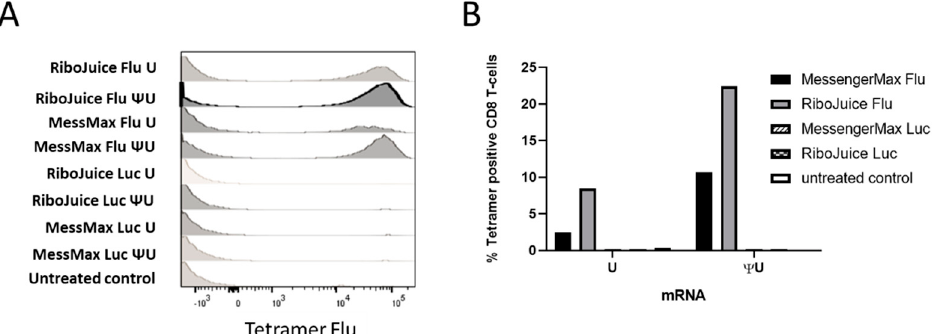
Figure 4. Monitoring of Flu M1-specific immune responses in human PBMCs following transfection with ivt mRNA coding the Flu matrix M1 protein. ( A ) At day 12 of culture, the cells were stained with antibodies and a fluorescent MHC class I tetramer specific for Flu M1 HLA-A*0201-restricted T cells, and analyzed by FACS. ( B ) Comparison of the percentage of Flu M1 MC class I tetramer positive T cells after transfection with immuno-stimulating (“U”) or immuno-silent (“ Ψ U”) mRNA coding for the Flu M1 HLA-A*0201 epitope.